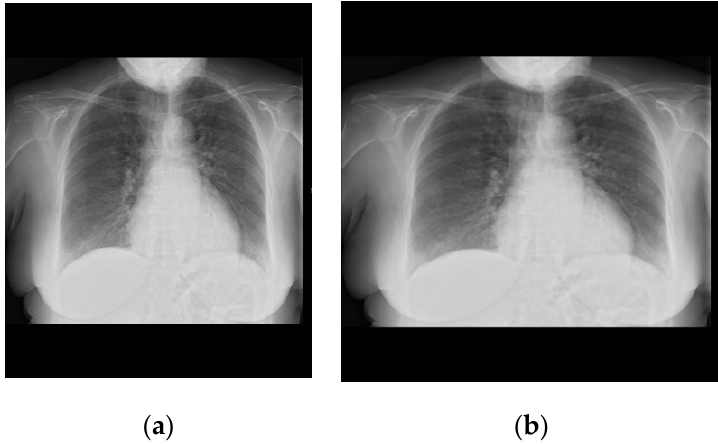
Figure 5. Distortion due to resizing the images to square shape. ( a ) Shows the original shape of a CXR of a patient with COVID-19; ( b ) shows the resized image to squared shape. Original images are from (https: // github.com / ieee8023 /